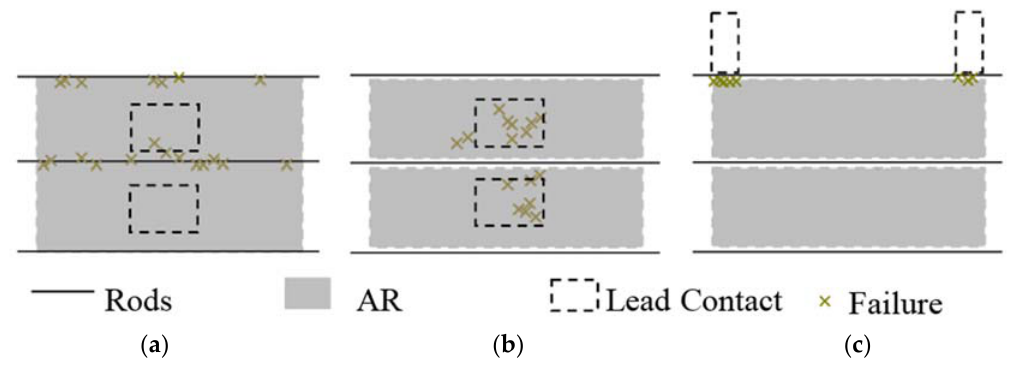
Figure 9. Recorded failure occurrence in RP-DEAs: ( a ) with single AR over 20 samples (Case 1); ( b ) with separate ARs over 16 samples (Case 2); and ( c ) with separate ARs and optimized connection over 10 samples (Case 3).